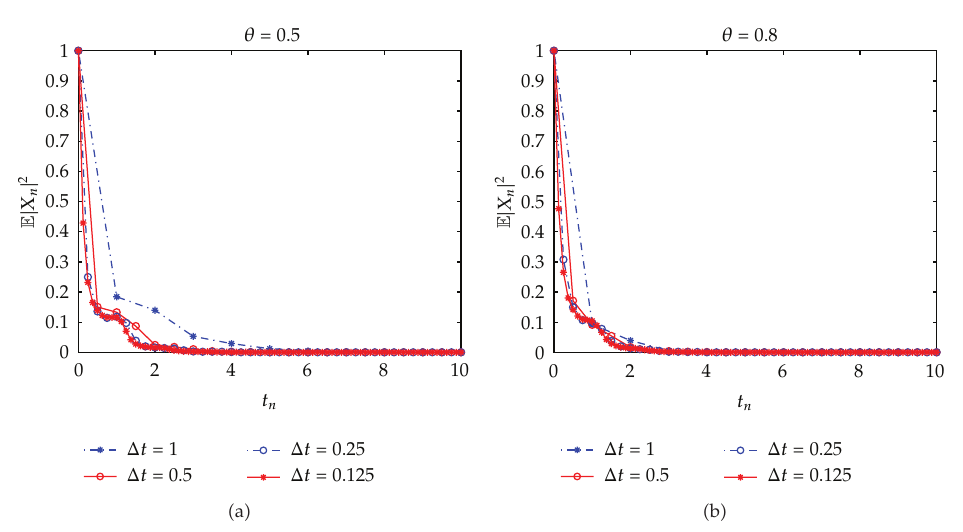
Figure 1: Fixed θ (cid:7) 0 . 5 (cid:3) a (cid:4) and θ (cid:7) 0 . 8 (cid:3) b (cid:4) with di ff erent stepsize Δ t (cid:7) 1 / 8 , 1 / 4 , 1 / 2 ,